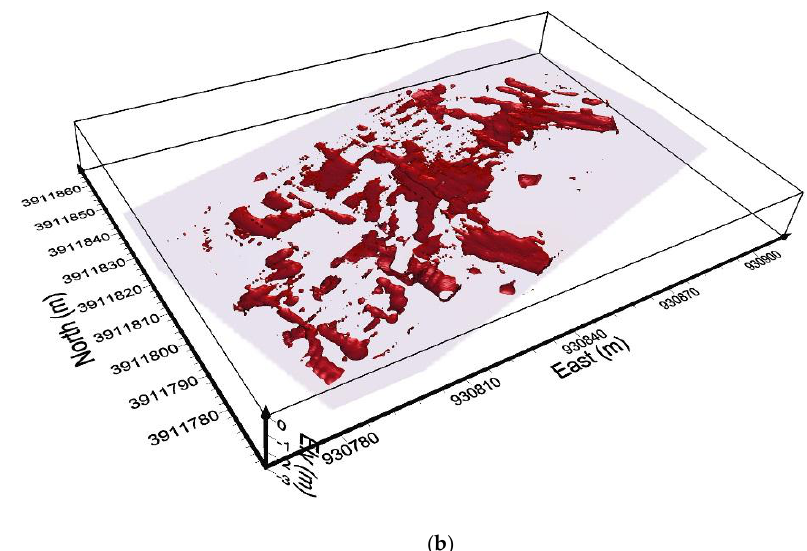
Figure 11. ( a ) Depth slices up to 2 m below the sea bottom extracted from the 3-D merged inversion models of the grids covering the marine surveyed area in Olous; ( b ) Isosurface model of high resistivity anomalies (more than 5 Ohm-m) that correspond to the buried architectural remains in Olous.